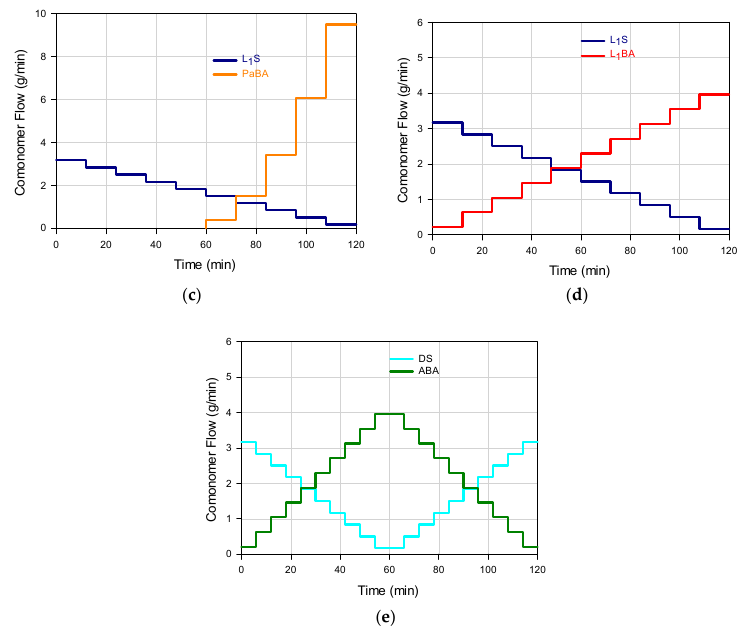
Figure 1. Comonomers flow as a function of reaction time, for S/BA FCCs synthesis: ( a ) M 1 (L 2 S/L 1 BA); ( b ) M 2 (PaS/L 1 BA); ( c ) M 3 (L 1 S/PaBA); ( d ) M 4 (L 1 S/L 1 BA); and ( e ) M 5 (DS/ABA). For the characterization of each FCC material, seven samples were extracted at predetermined reaction times, to be measured by 1 H-NMR (Varian Gemini 2000, Agilent Technologies, Palo Alto, CA, USA) their respective global styrene percentage ( (cid:1845)(cid:1842) (cid:2915)(cid:2934)(cid:2926) values) and, by gravimetry their respective global conversion values ( (cid:1850) (cid:2915)(cid:2934)(cid:2926) values). For the calculations to build up the WCD, the conversion interval (from 0% up to the final experimental conversion value) was discretized in subintervals of 0.1% in width. It was considered that all the chains produced inside of each conversion subinterval i (characterized by its respective (cid:1850) (cid:3036) value) have the same (cid:1845)(cid:1842) (cid:2919) value, which was estimated with a third order polynomial obtained by fitting the seven above mentioned experimental values; for this, the least squares method was used. The total mass of monomer j (S or